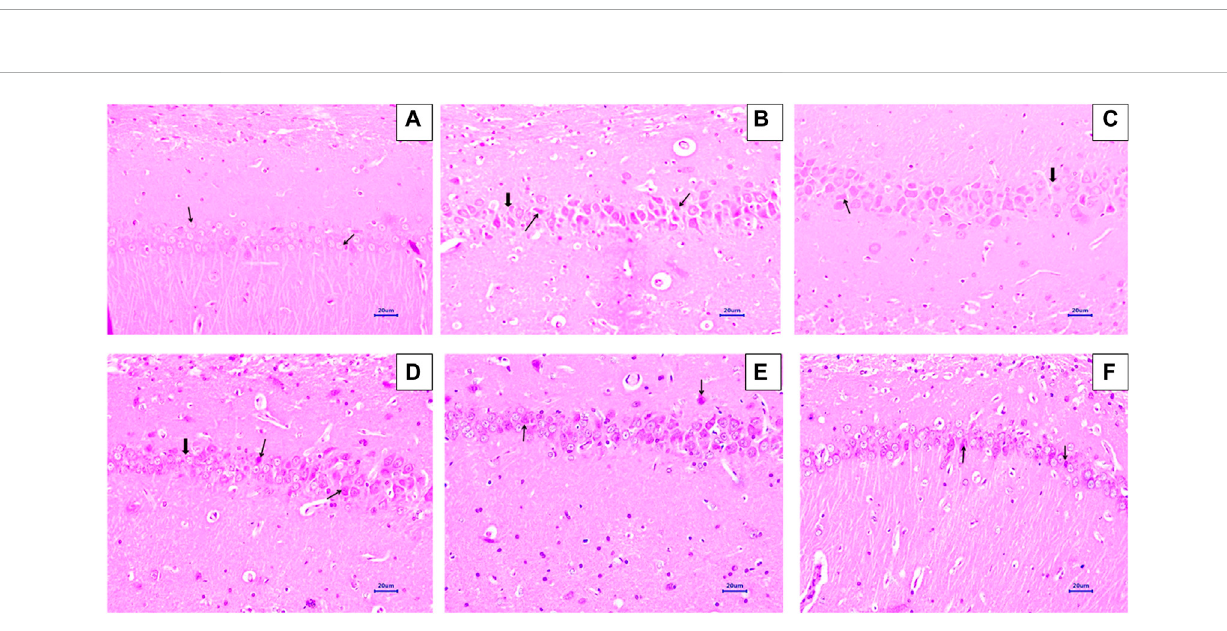
FIGURE 3 EffectsofbaicaleinandbaicaleinwithmemantineonH&E-stainedhippocampustissue(400X), (A) Normalcontrol:showingnormalhistologyandnormal neuronal cells in the hippocampus (small arrow) (B) Disease control: hippocampus neuronal degeneration with pyknotic nuclei (small arrow), hippocampus neuronal cell layer reduction (large arrow) (C) Memantine (20 mg/kg): hippocampus neuronal degeneration with pyknotic nuclei (small arrow), hippocampus neuronal cell layer reduction (large arrow) (D) Baicalein (10 mg/kg): hippocampus neuronal degeneration with pyknotic nuclei (small arrow), hippocampus neuronal cell layer reduction (large arrow) (E) Memantine + baicalein (20+5 mg/kg): hippocampus neuronal degeneration with pyknotic nuclei (small arrow) (F) Memantine + baicalein (20 + 10 mg/kg): hippocampus neuronal degeneration with pyknotic nuclei (small